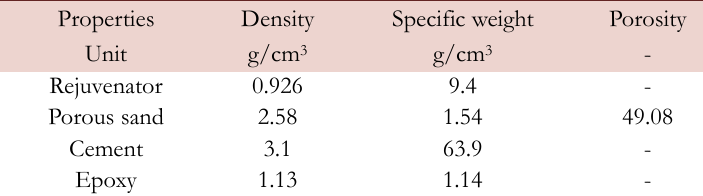
Table 1: Properties of the materials forming the capsules.